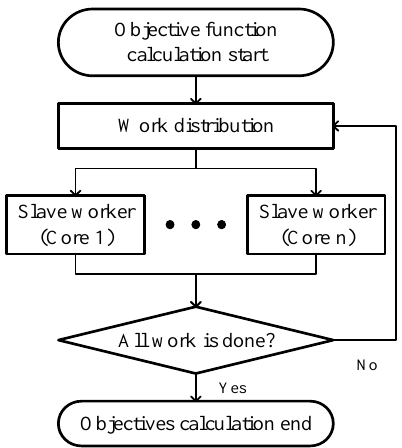
Figure 8. Objectives parallel computing flowchart [29]. Table 3. Pseudo code for master–slave parallel genetic algorithm (MSPGA) using MATLAB.